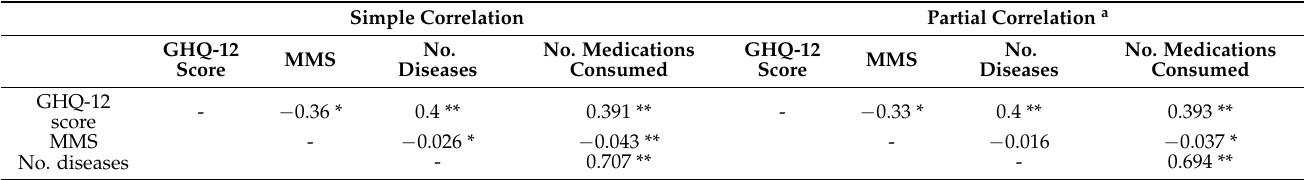
Figure 2. ROC curve that summarizes the potential of the number of medications consumed in the last 2 weeks to identify cases of mental health vulnerability ( a ) depression in the last 12 months ( b ), anxiety in the last 12 months ( c ) and multimorbidity ( d ). Table 2. Bivariate correlations between GHQ-12 score with MMS, the number of diseases and number of medications consumed in the last 2